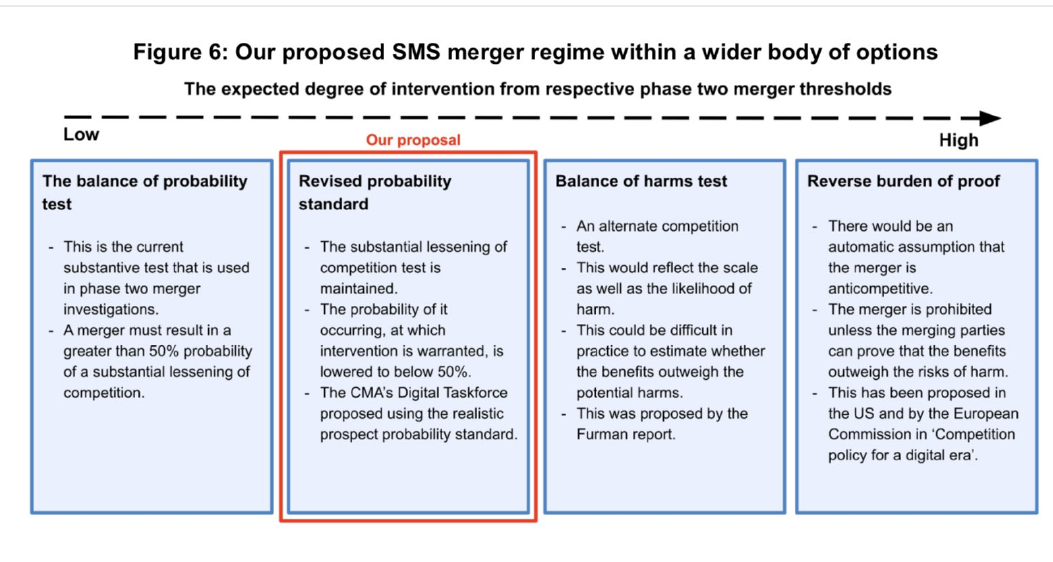
FIGURE 1: UK government proposal for a revised digital market merger